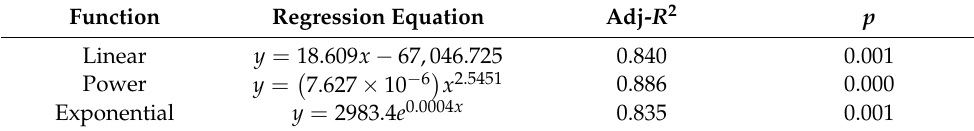
Table 5. Modelling results for annual night-light data obtained by the annual average method. Function Regression Equation Adj- R 2 Linear